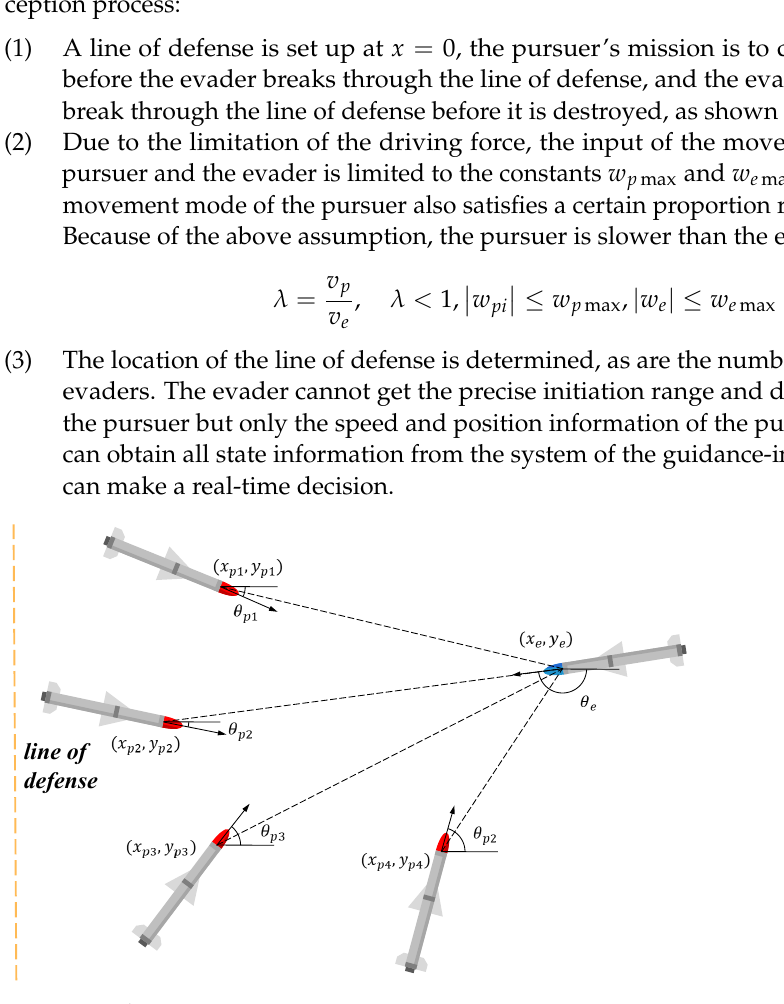
Figure 1. Relative